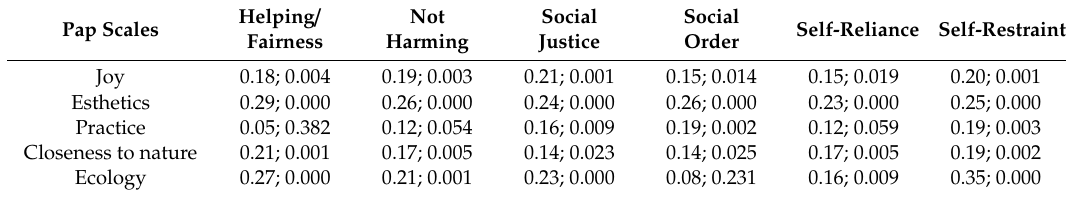
Table 2. The connection between attitudes toward the plant world and moral motives (Spearman r). Pap